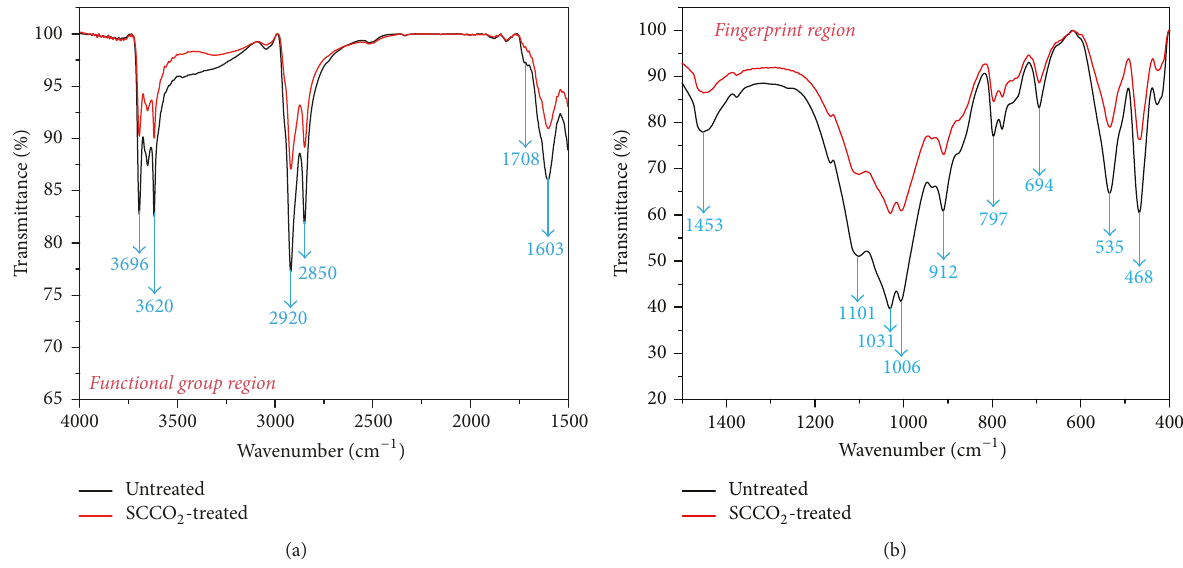
Figure 8: Infrared spectrogram of functional group region (4000–1500cm −1 ) and the fingerprint region (1500–400cm −1 ) for oil shale before and after SCCO 2 treatment.